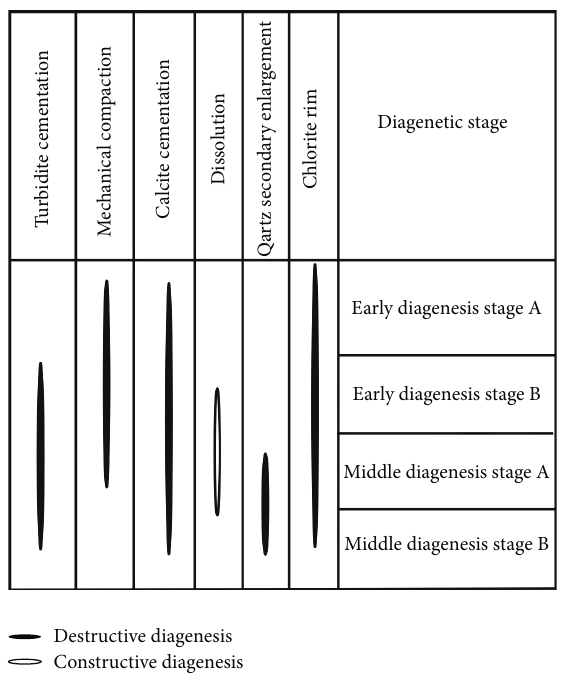
Figure 8: Main diagenetic sequence of Chang 6 Formation of the Yanchang